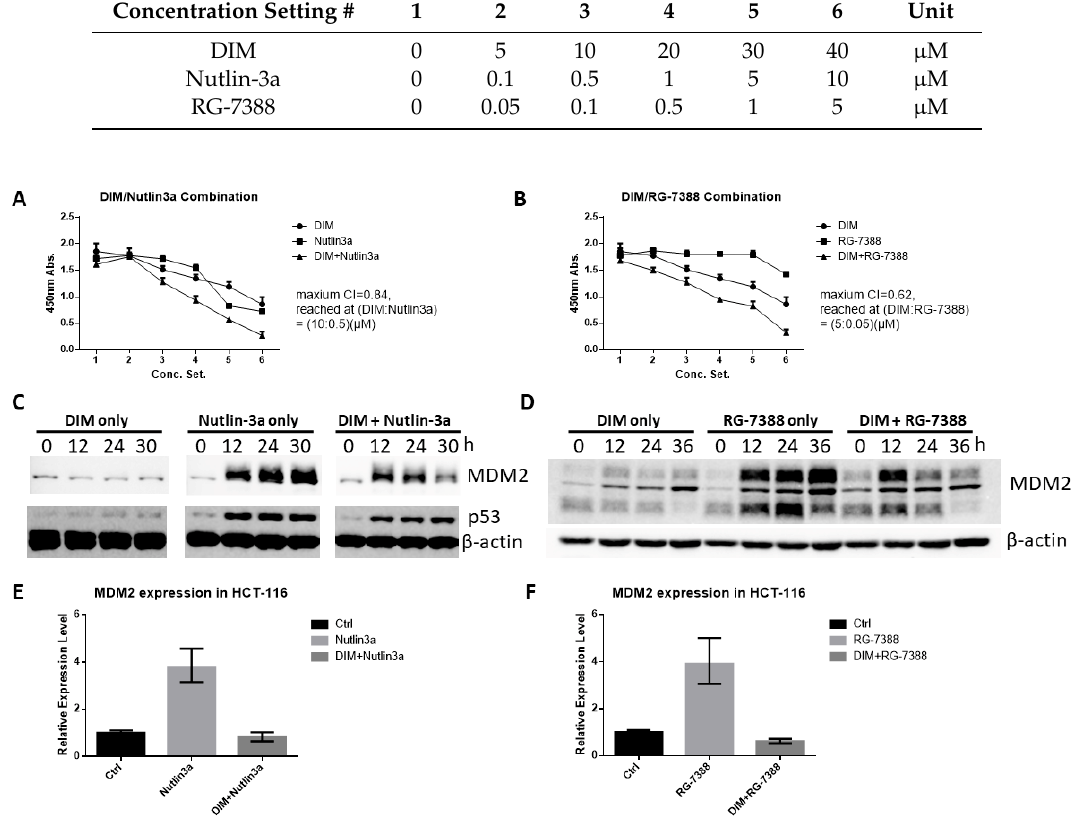
Figure 6. DIM enhanced the anti-cancer activity of Nutlin-3a and RG-7388. HCT-116 cells were treated with a single agent or DIM in combination with Nutlin-3a ( A ) or RG-7388 ( B ). Cell proliferation was determined by WST-1 assay. The combination index (CI) was calculated by CompuSyn [23]. ( C ) HCT-116 cells were treated with a single agent of Nutlin-3a (10 µ M) or a combination of Nutlin-3a and DIM (40 µ M). Western blotting was performed using the indicated antibodies. ( D ) HCT-116 cells were treated with a single agent of RG-7388 (5 µ M) or a combination of RG-7388 and DIM (40 µ M). Western blotting was performed using the indicated antibodies. ( E , F ) HCT-116 cells were treated for 6 h with a single agent or a combination of DIM (40 µ M), Nutlin3a (10 µ M), and RG-7388 (5 µ M). MDM2 mRNA expression was analyzed as described in Materials and Methods.